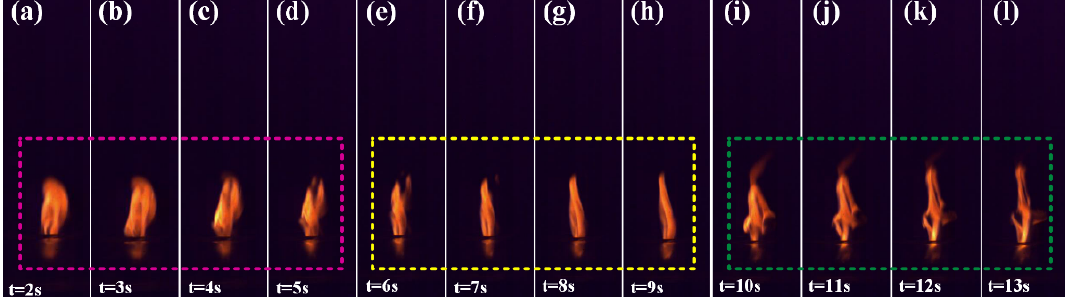
Figure 15. Combustion effect diagram of the 3D-printed grain at different times: ( a ) t = 2 s; ( b ) t = 3 s; ( c ) t = 4 s; ( d ) t = 5 s; ( e ) t = 6 s; ( f ) t = 7 s; ( g ) t = 8 s; ( h ) t = 9 s; ( i ) t = 10 s; ( j ) t = 11 s; ( k ) t = 12 s; ( l ) t = 13 s.